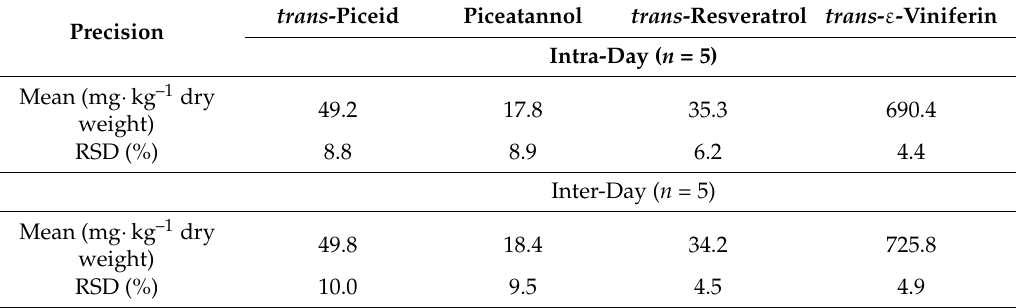
Table 3. Intra- and inter-day precision of analyzed stilbenes in Palomino fino 2011 grape cane